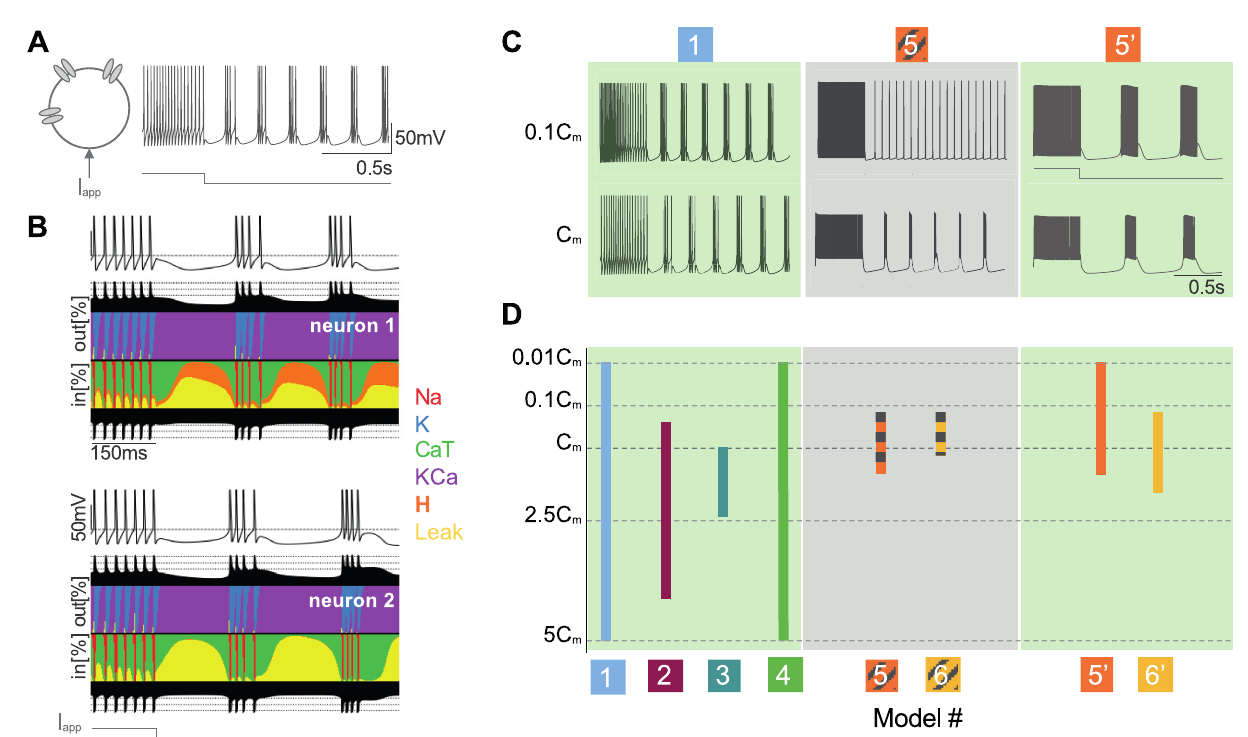
Fig 1. Slow T-type calcium channel activation ensures model robustness against neuron variability at single-cell level. A : The cell switches from a regular tonic mode to a bursting mode when a hyperpolarizing current is applied, a typical response called hyperpolarized-induced bursting (HIB). B : Currentscape for a neuron model with two different sets of maximal intrinsic conductances. After 150ms, the two neurons are hyperpolarized, leading to a HIB. Under the membrane-time curve, the black surface shows respectively on the top and bottom total inward outward currents on a logarithmic scale (see [45]). Between the black surfaces, each color curve reveals the contribution of one particular ionic current as the percentage of the total current during the simulation. Both neurons display the same firing pattern but this outcome is achieved by different combinations of ion channels densities. C : Models 1, 2, 3, 4, 5’ and 6’ are robust to a uniform scaling of all the maximal conductances, modeled by a change in membrane capacitance ( C panel). Models 5 and 6 are fragile to this parameter alteration. They lose the ability to switch (center panel). Restoring the slow CaT channel activation is enough to recover the robustness (right panel). D : Quantitative analysis of neuron model robustness to change in membrane capacitance. Each model is launched for a capacitance value varying from a hundredth to five times its nominal value. Models 1, 2, 3, 4, 5’ and 6’ cover larger parameter range. By contrast, models lacking of slow CaT channel activation are fragile to membrane capacitance deviation. Replacing the instantaneous CaT channel activation by a slow activation turns these fragile models into more robust models. Hence, models 5’ and 6’ support larger variation of C